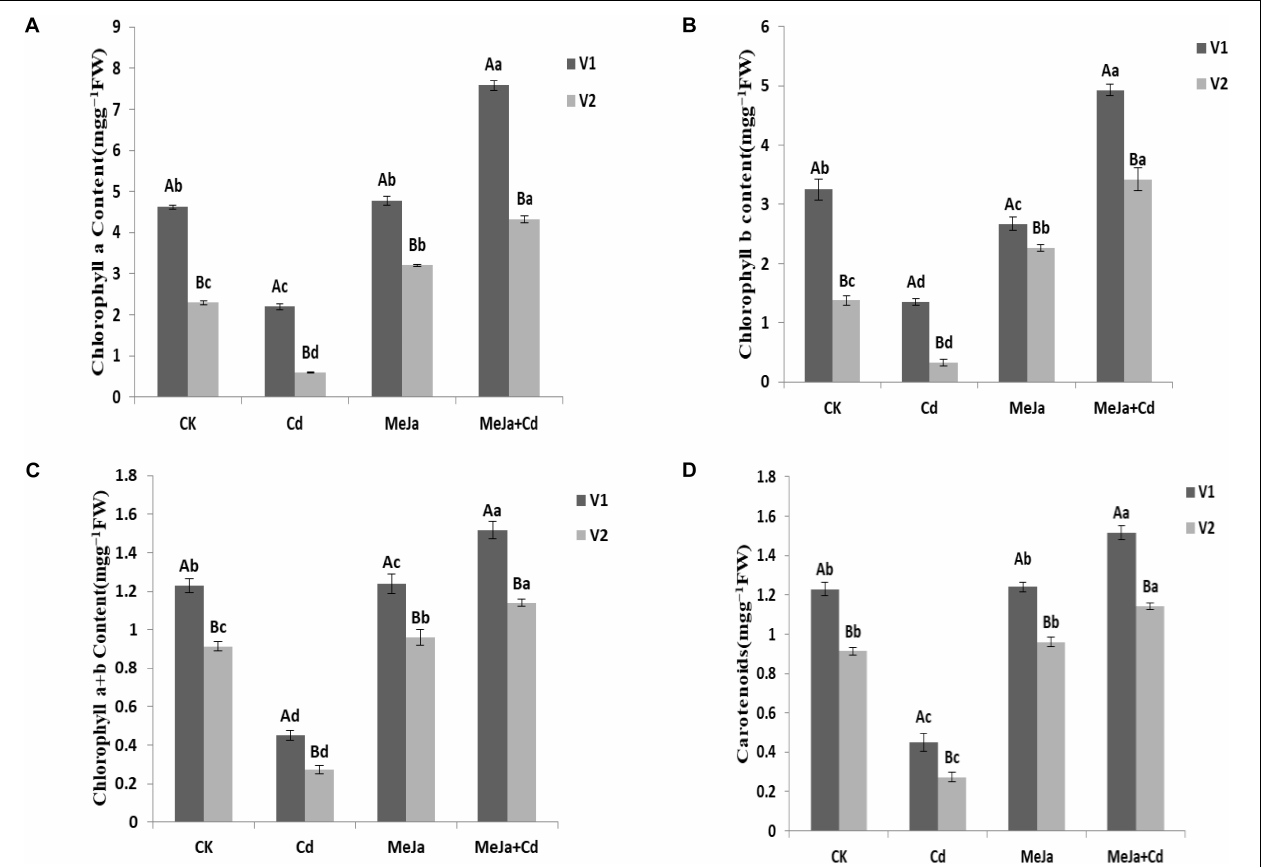
FIGURE 1 | The effects of MeJa on (A) Chl a, (B) Chl b, (C) Chl a + b, and (D) carotenoids in two rice cultivars under Cd stress. The values are representative of three replicated means per treatment ± SE. Different letters indicate significant differences between cultivars and treatments at p < 0.05, LSD (V1 = Xiangyaxiangzhan and V2 =